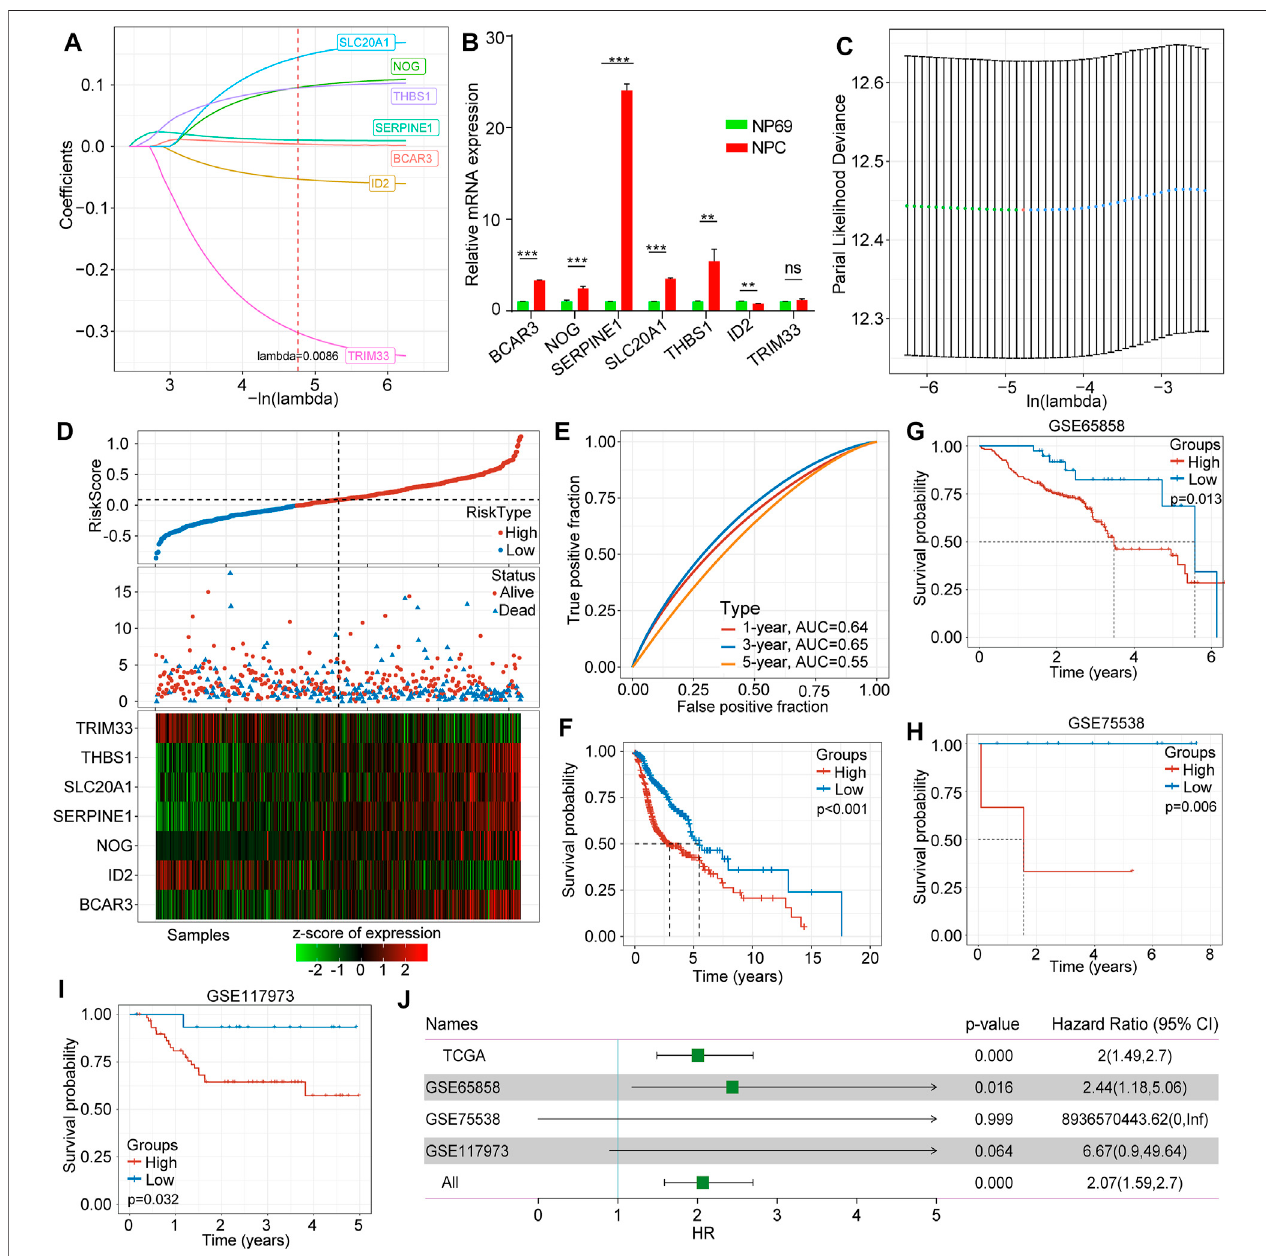
FIGURE 2 | Construction and validation of the TGF- β -associated prognostic risk score model. (A) The trajectory of each selected gene in TGF- β pathways. (B) Expression levels of hub genes in human nasopharyngeal carcinoma cell NPC and human immortalized nasopharyngeal epithelial cell NP69 by qRT-PCR. (C) The con fi denceintervalofeachlambda. (D) Correlations anddistribution ofriskscore,survivaltimeandsurvivalstatusandexpressionlevelsofthesevenselectedgenes. (E) The classi fi cation ef fi ciency of prognostic prediction for HNSCC at 1 year, 3 years, and 5 years. (F) The survival curve between high- and low-risk scores of the seven-gene signature. (G) The survival curve between high- and low-risk score subgroups in GSE65858. (H) The survival curve between high- and low-risk score subgroups in GSE755538. (I) The survival curve between high- and low-risk score subgroups in GSE117973. (J) Forest plots of risk scores in different datasets.